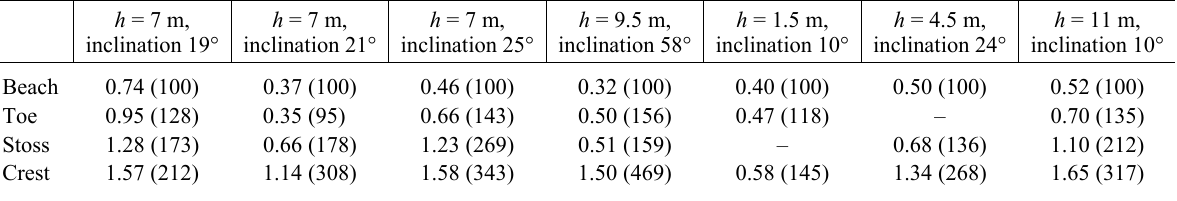
Table 1. Variations in shear velocity ( U *) above foredunes with different slope inclinations and relative heights. In brackets (cid:150) portion of U * (%) in the beach value h = 7 m, inclination